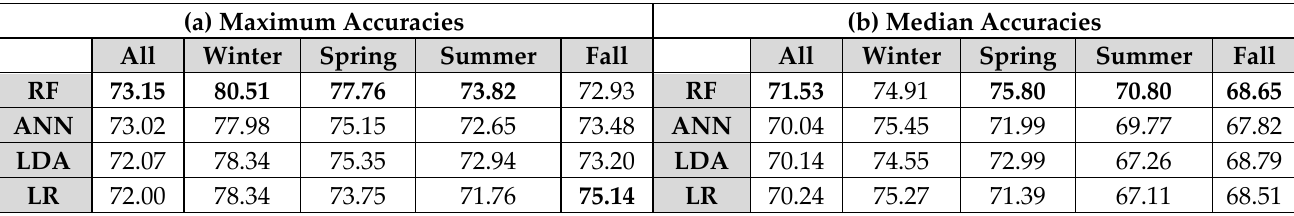
Table 5. ( a ) Maximum accuracies and ( b ) median accuracies for all datasets and for each season, indicating the performances of the algorithms RF, ANN, LDA, and LR.